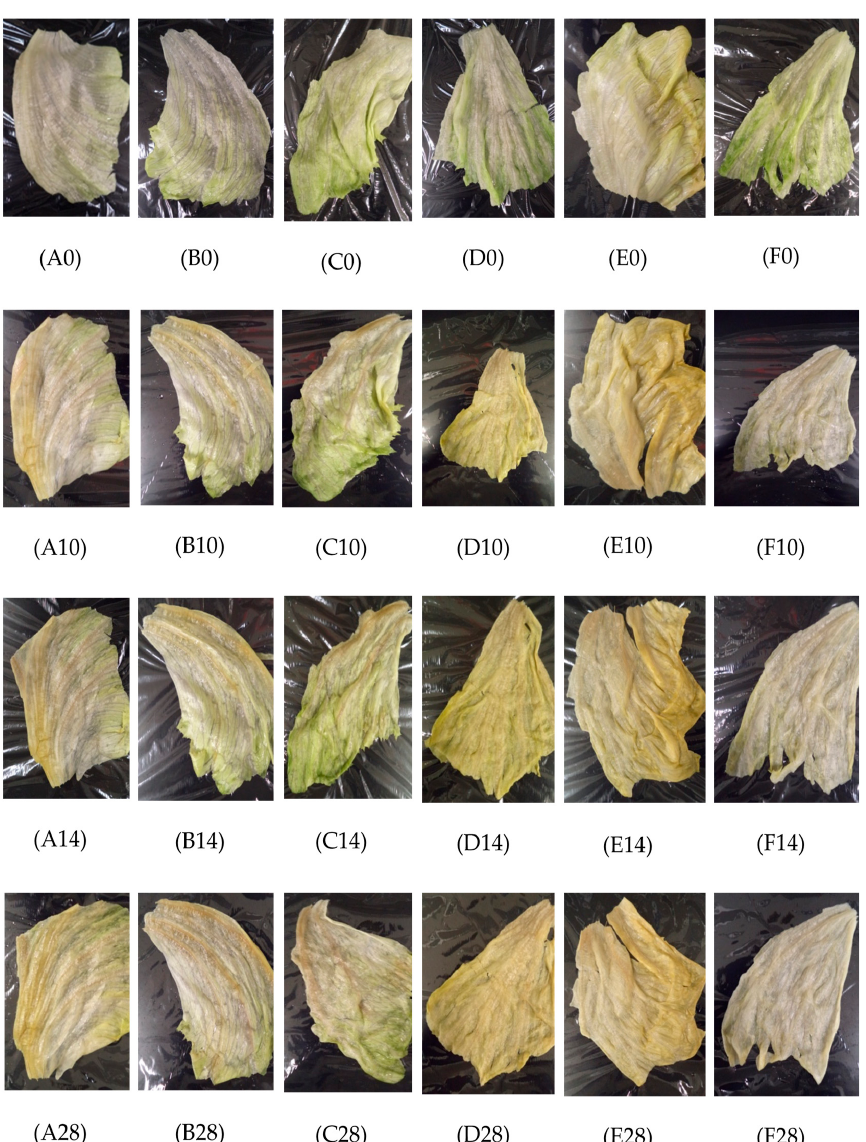
Figure 2. Visual observation of Iceberg lettuce leaves inoculated with E. coli O157:H7, and treated with 50 ppm chlorine, 3% hydrogen peroxide, and plant-based microemulsions and stored at 4 °C for 28 days. Letters denoted represent positive control (A0) on day 0, (A10) on day 10, (A14) on day 14, and (A28) on day 28; 50 ppm chlorine (B0) on day 0, (B10) on day 10, (B14) on day 14, and (B28) on day 28; 3% hydrogen peroxide (C0) on day 0, (C10) on day 10, (C14) on day 14, and (C28) on day 28; 0.3% oregano oil microemulsion (D0) on day 0, (D10) on day 10, (D14) on day 14, and (D28) on day 28; 0.5% cinnamon oil microemulsion (E0) on day 0, (E10) on day 10, (E14) on day 14, and (E28) on day 28; 0.5% lemongrass oil microemulsion (F0) on day 0, (F10) on day 10, (F14) on day 14, and (F28) on day